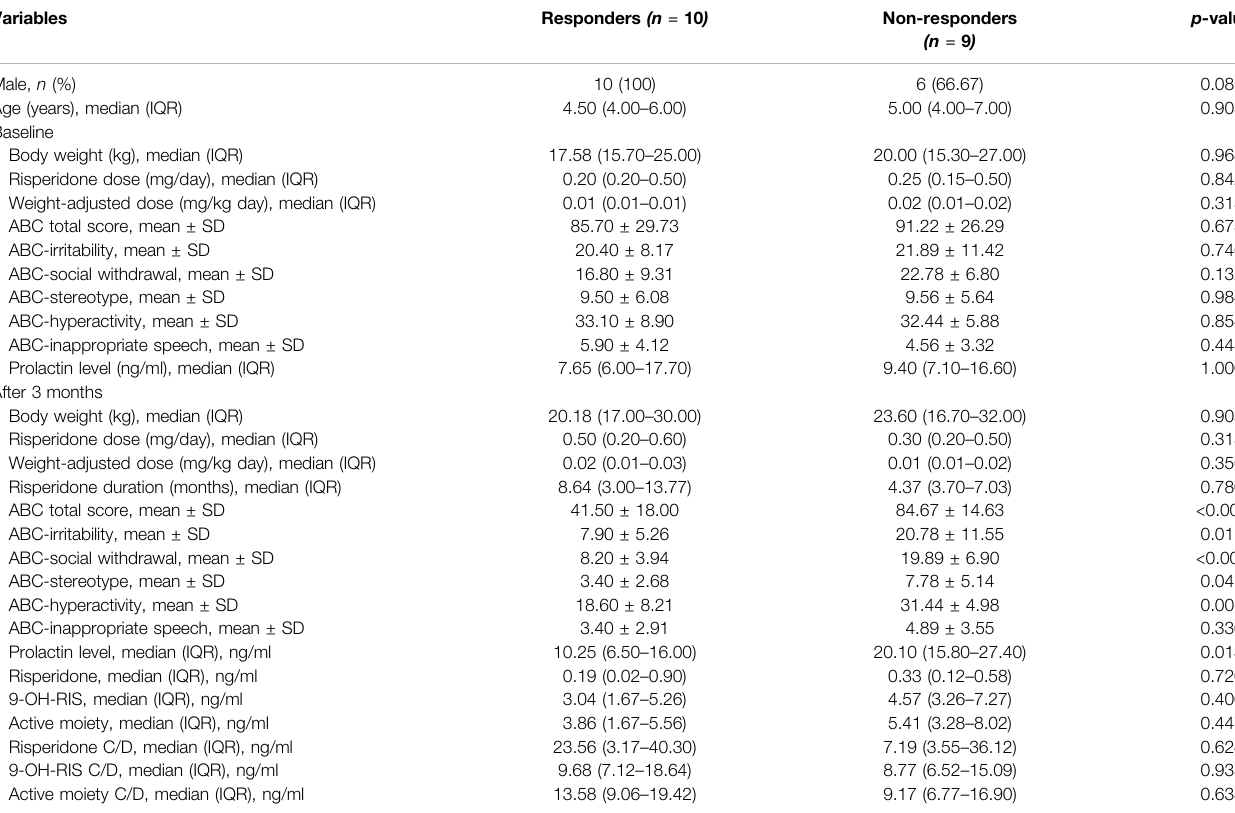
TABLE 5 | ABC score and serum prolactin levels at baseline and after 3 months of treatment between responders and non-responders ( n (cid:1)